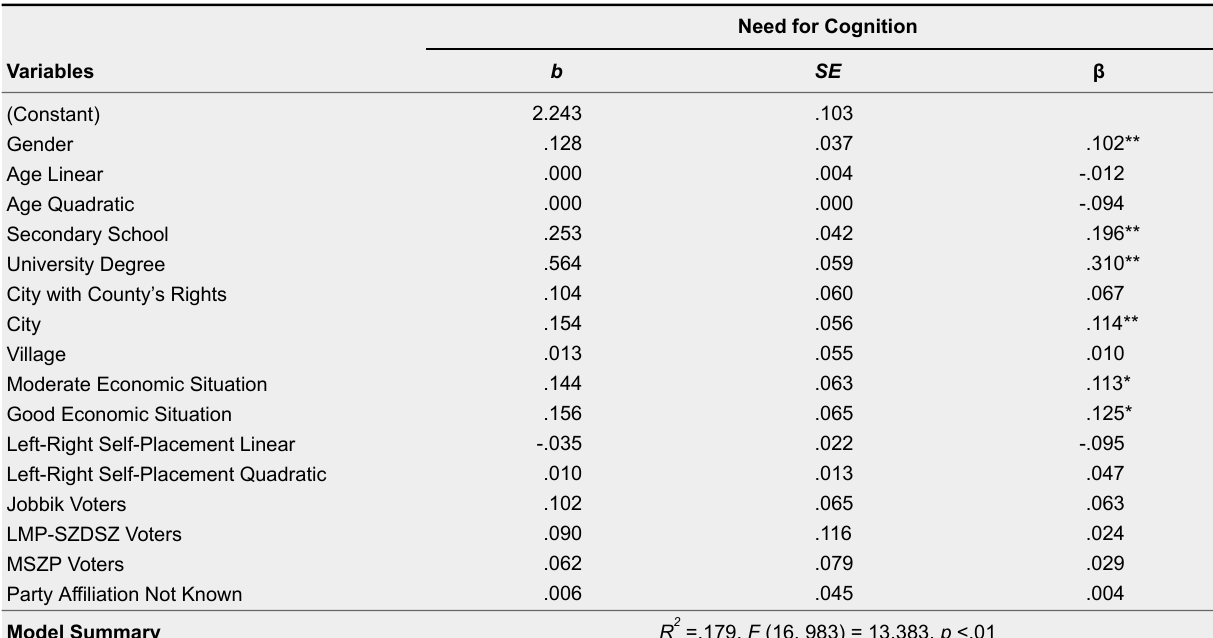
Multiple Regression Analysis After the Second Set of Predictors (Political Predictors) Were Added to the Model. Dependent Variable: Need for Cognition (N = 1000)